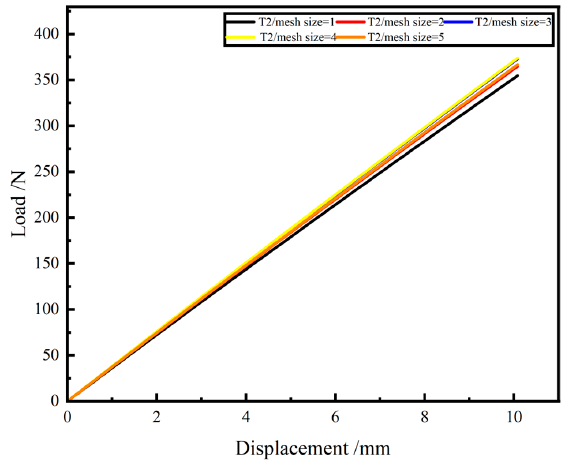
Figure 5. Stiffness simulation results for different mesh sizes.